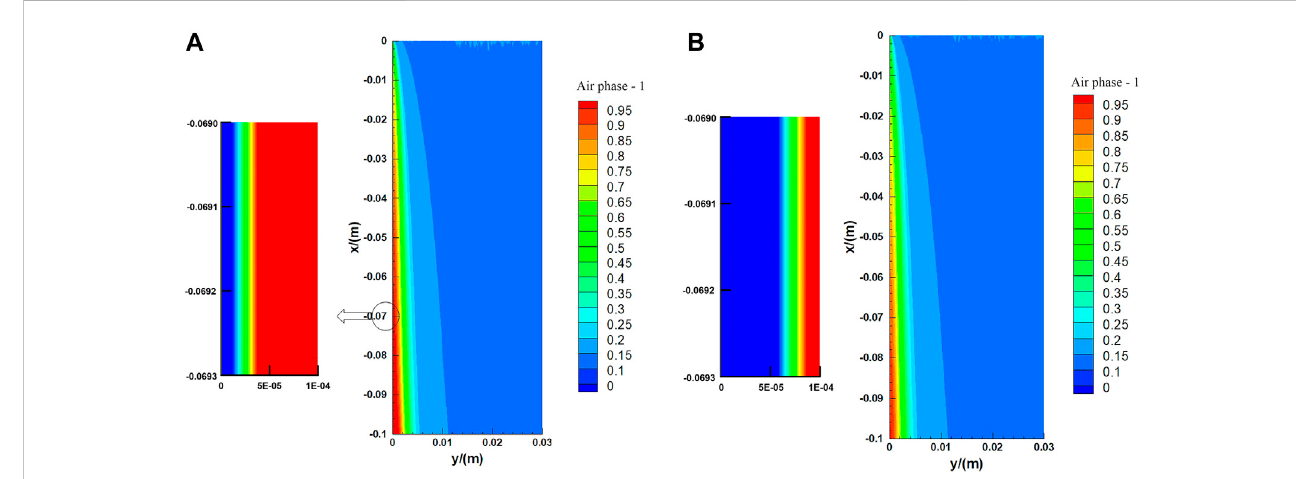
FIGURE 7 Mass fractions of air on the phase interface in Case 2: (A) t = 0.5 s; (B) t = 4.25 s.